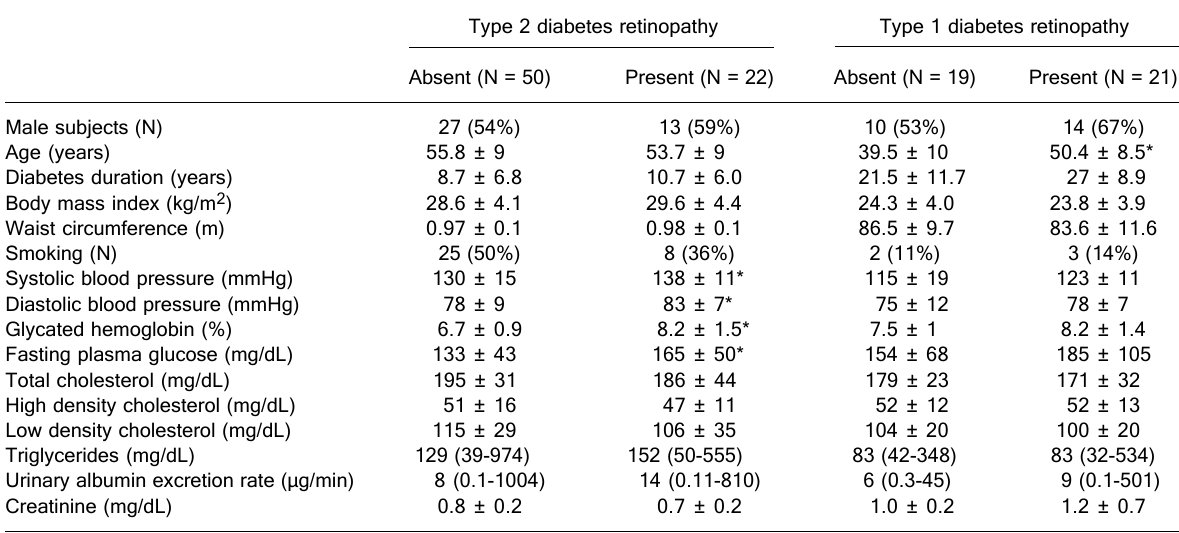
Table 1. Clinical and laboratory characteristics as a function of the presence of diabetic retinopathy in type 2 and type 1 diabetic